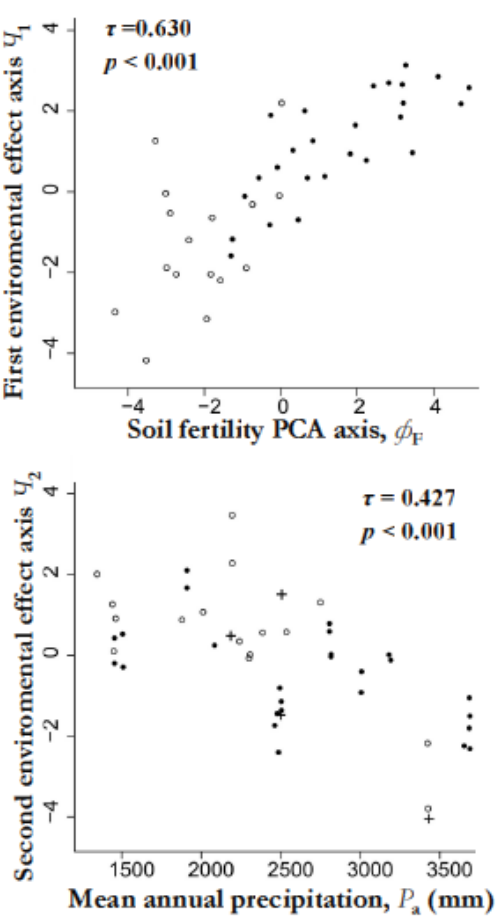
Fig. 9. Relationship between derived environmental effect principal components (Table 5) and soil/environmental parameters for vari- ous plots across the Amazon. Top panel, first principal component of the environmental effects versus the first principal component of the PCA of soil chemical and physical characteristics as derived by Fyllas et al. (2009) on the basis of data provided by Quesada et al. (2010). Second panel, second principal component of the envi- ronmental effects PCA versus mean annual precipitation. Open cir- cles indicate low fertility sites and the closed circles indicate high fertility sites as defined by Fyllas et al.